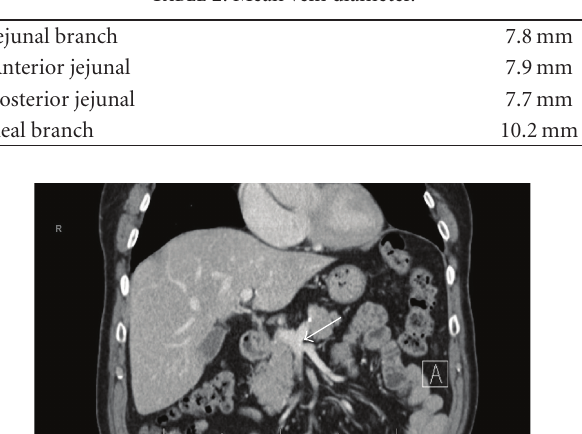
Figure 3: No Common SMV Trunk. Jejunal and ileal branches joining at splenoportal